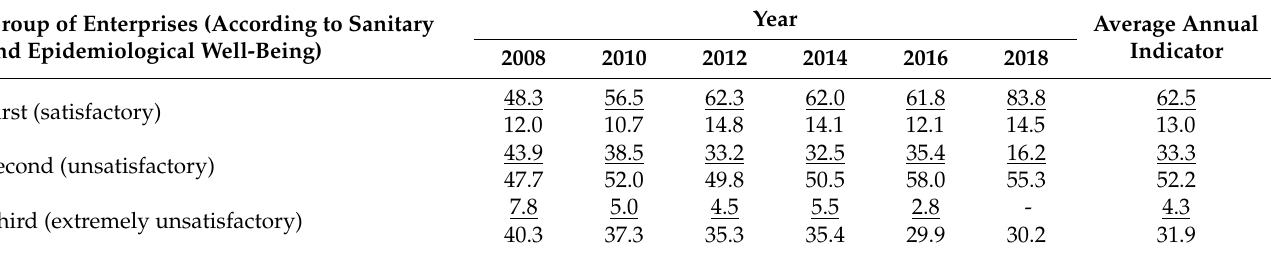
Table 2. Share of workers at enterprises of three groups of sanitary-epidemiological well-being (%). Group of Enterprises (According to Sanitary and Epidemiological Well-Being)